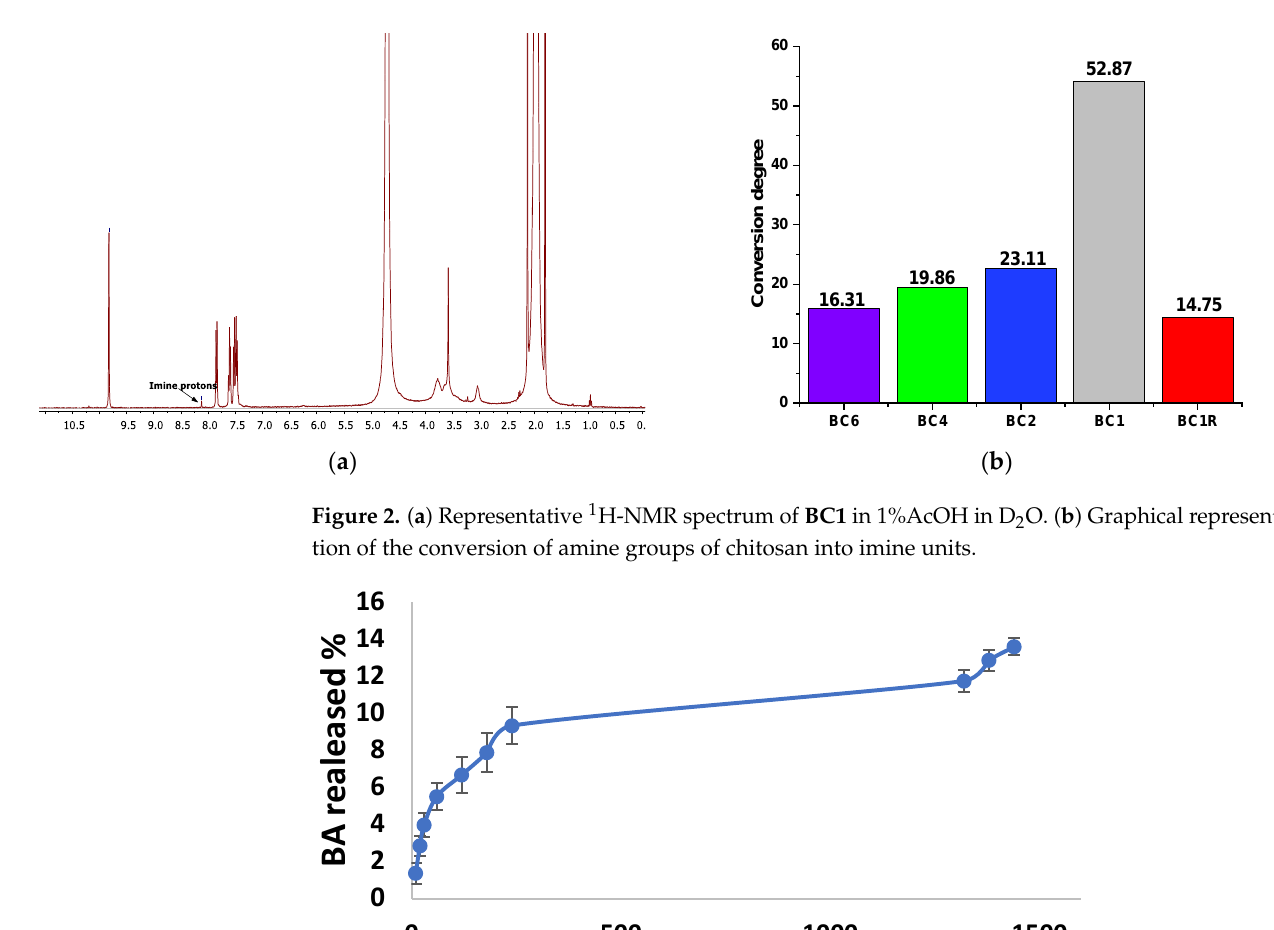
Figure 2. ( a ) Representative 1 H-NMR spectrum of BC1 in 1%AcOH in D 2 O. ( b ) Graphical represen- tation of the conversion of amine groups of chitosan into imine units.